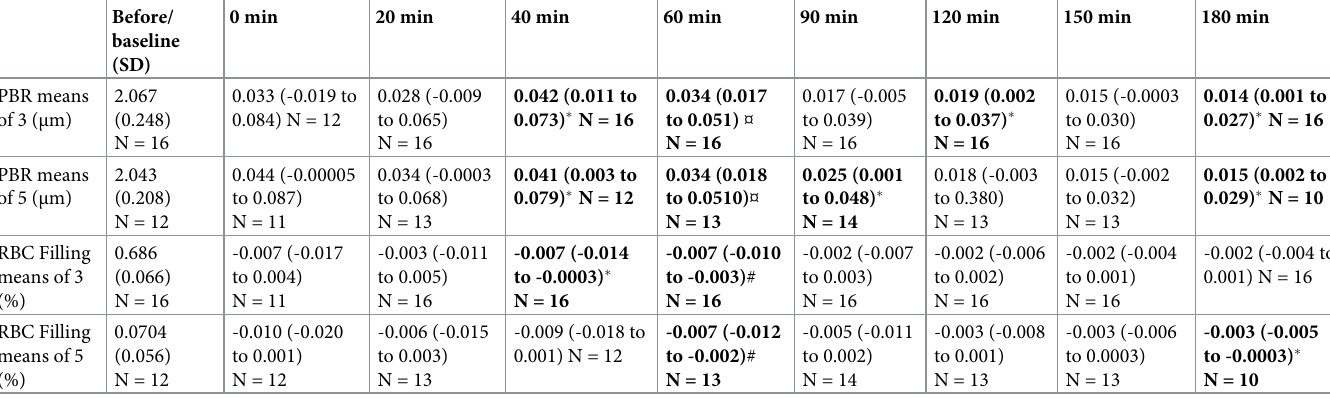
Coffee consumption (Table 6). Starting at a PBR for means of 3 and 5 measurements of PBR and a decrease in RBC filling for both means of 3 and 5 measurements already at time 0. Again, the largest change was at time 0 for PBR for means of 3 and 5 measurements being Table 4. Results of smoking a cigarette before and at times 0–180 min.